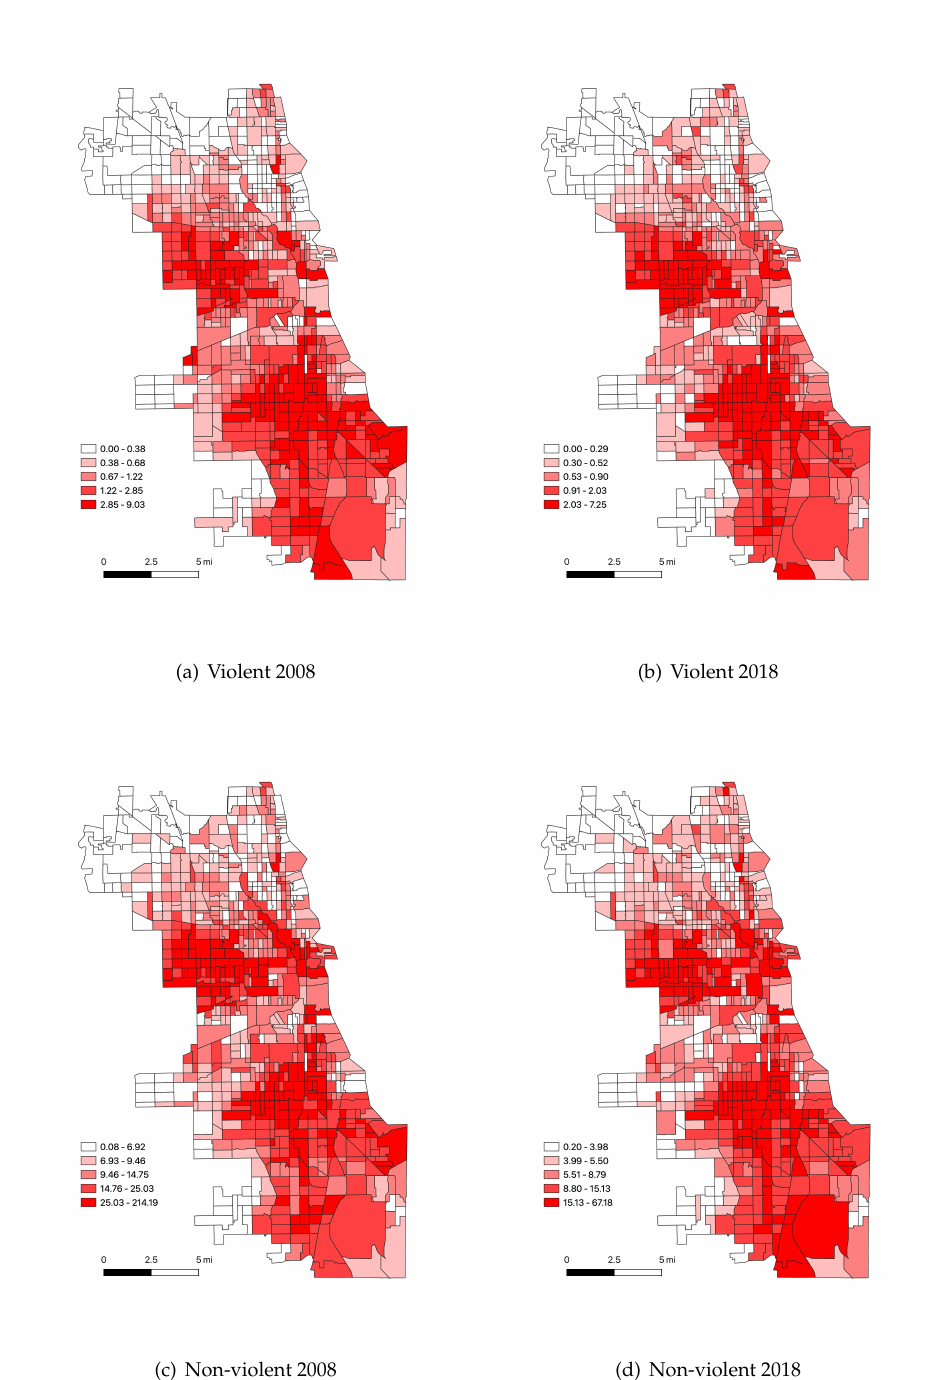
Figure 3: Violent and nonviolent crime rates per 100 population by census tract, 2008 and 2018. Mi, miles.